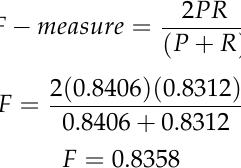
Figure 5. Web access of the digital thesaurus of ethnic groups in the MRM, showing a list of terms begin with A.